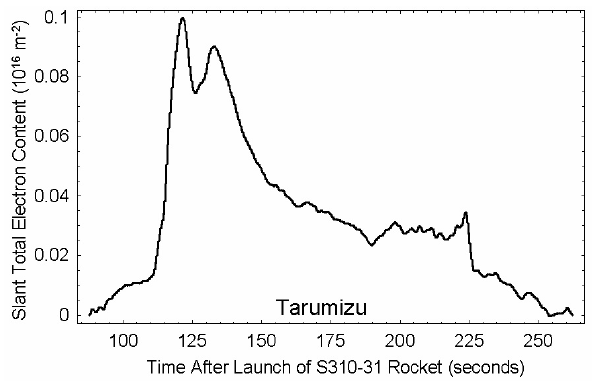
Fig. 4. TEC data from the DBB instrument on the second SEEK-2 rocket launched on 3 August 2002 at 14:39 GMT.